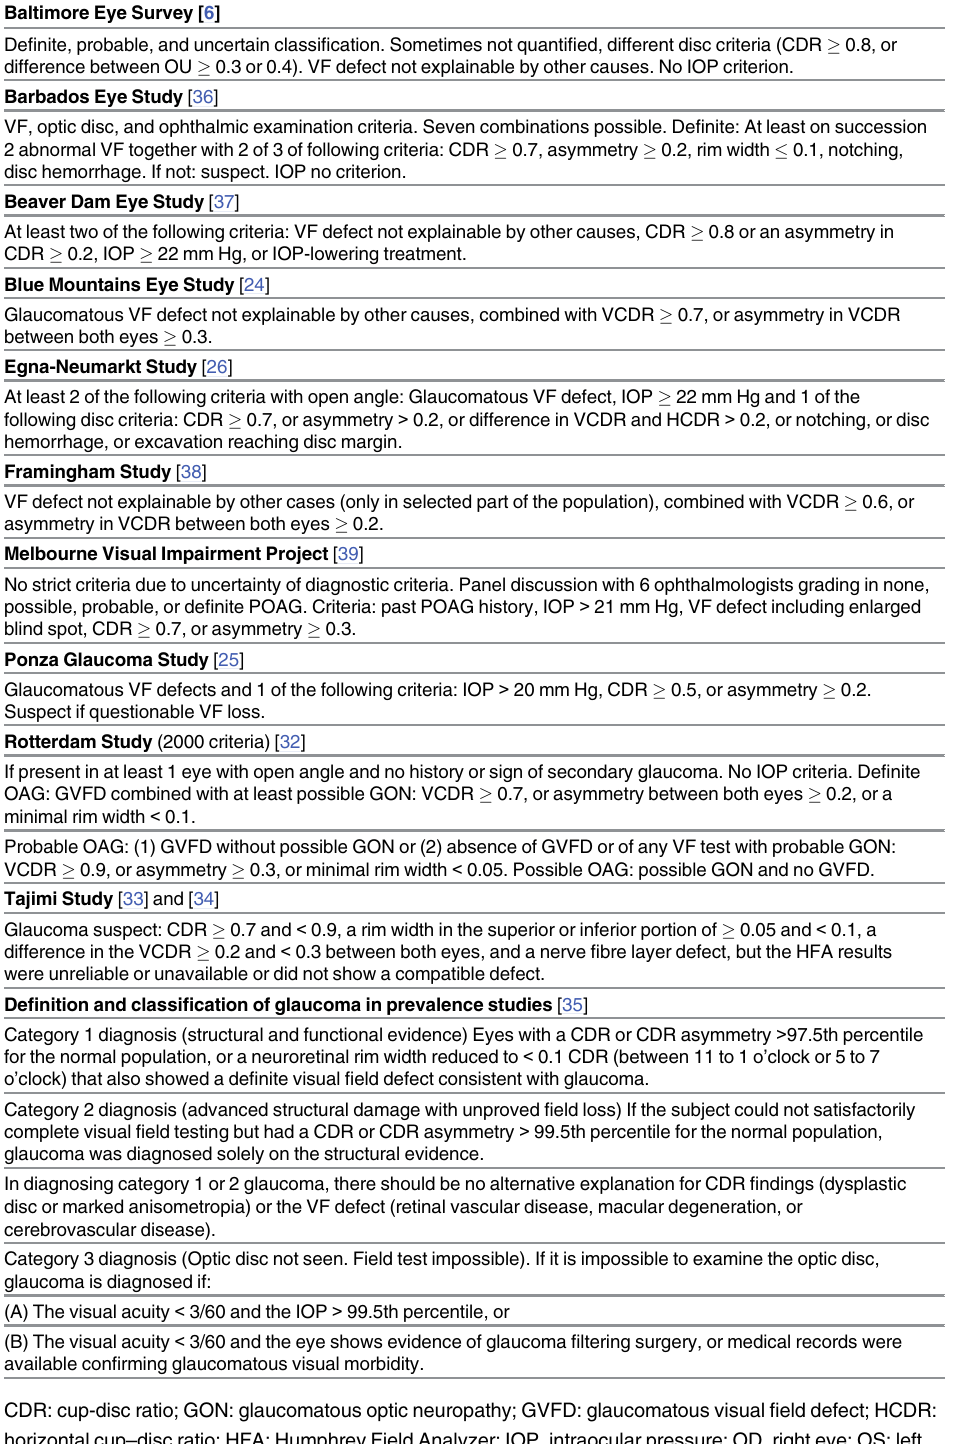
Table 12. Varying criteria in a diagnosis of glaucoma (according to [32]), complemented by the Tajimi study [33] and [34] and the definition of Foster et al.